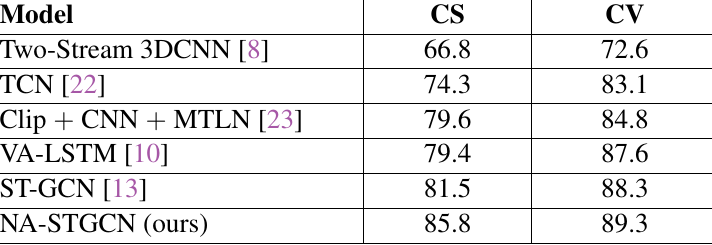
Table 1 Comparison with representative methods